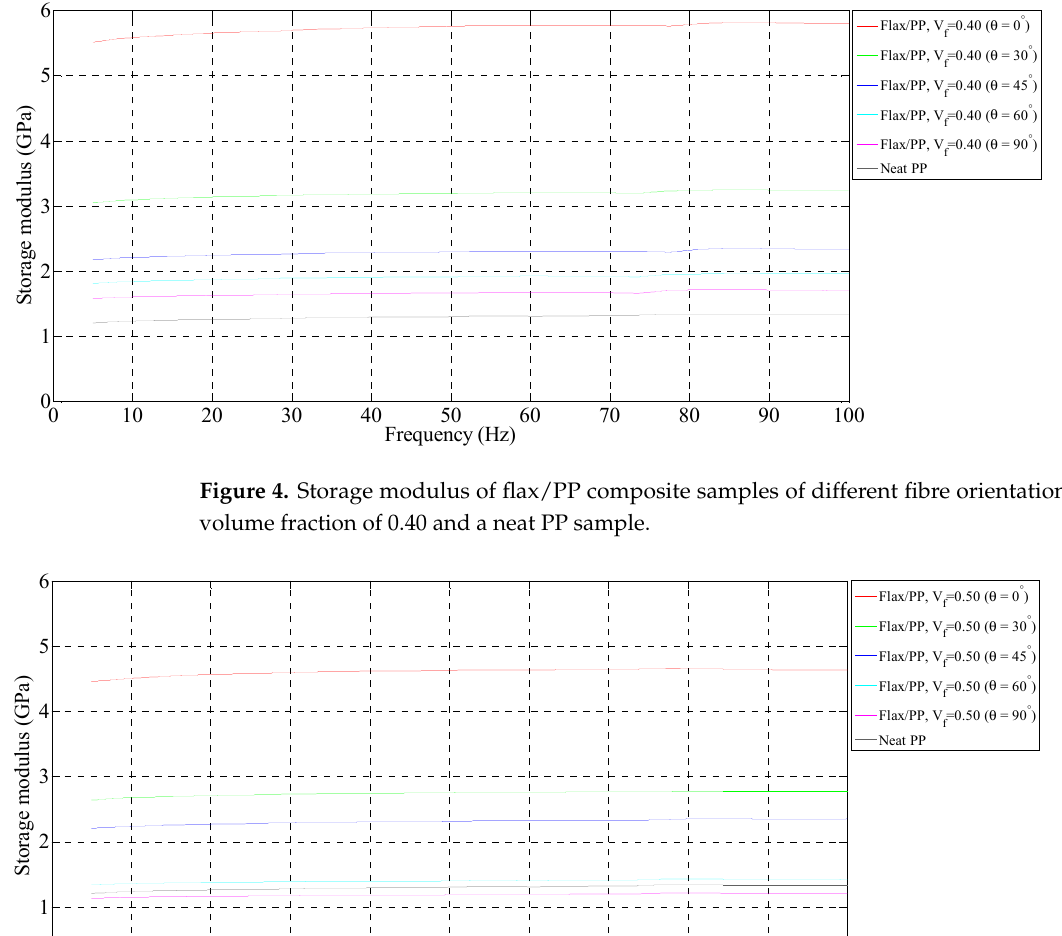
Figure 3. Storage modulus of flax/PP composite samples of different fibre orientations for a fibre volume fraction of 0.31 and a neat PP sample.